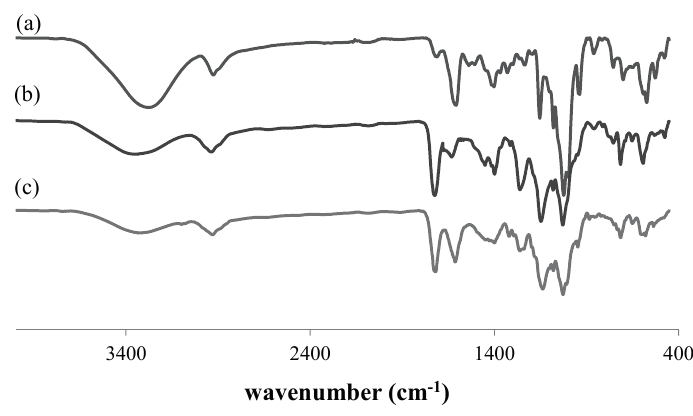
Figure 5. FTIR spectra of ( a ) HEMA- β -CD; ( b ) RAFT-MIP2; and ( c )